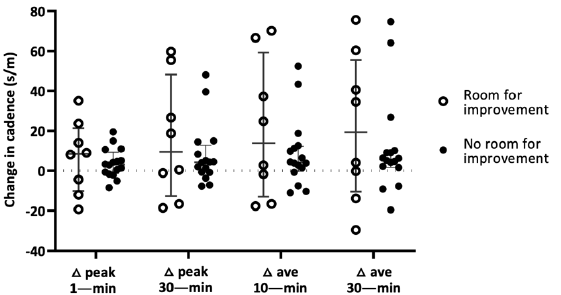
Figure 1. Changes in cadence values based on those with or without room for improvement according to objective physical function scores at baseline. Vertical bars represent the median (inner horizontal dash) and the interquartile range (outer horizontal dashes). Open circles represent individuals with room for improvement as determined by SPPB score of ≤10. Solid circles represent individuals with less room for improvement based on SPPB score of >10. Δ: change. s/m: steps per minute.